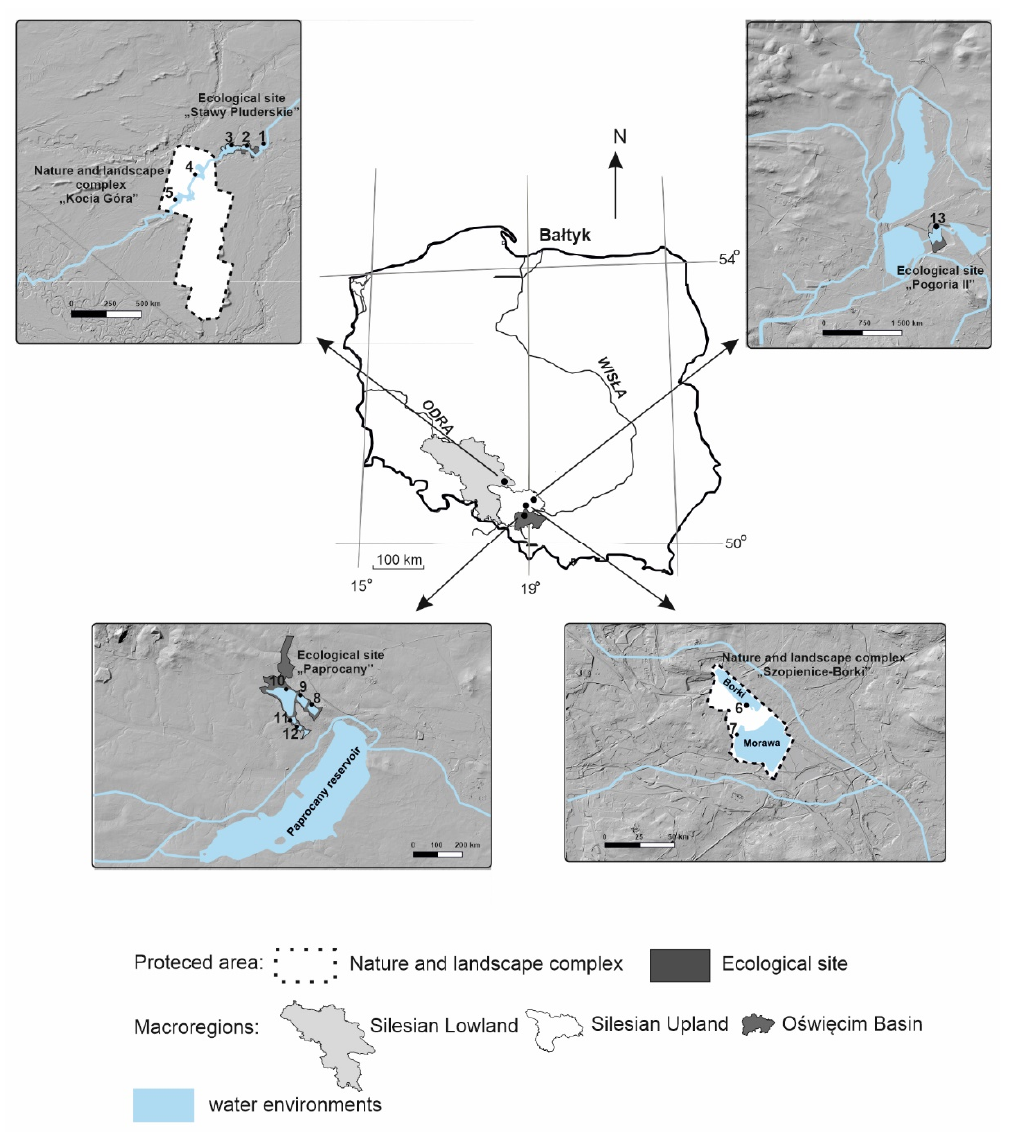
Figure 1. Location of the studied water bodies in the five protected complexes in Poland; 1–13 water bodies studied. Table 1. Environmental characteristics of the water bodies covered with different forms of habitat protection; Aquatic plant identification was performed by the authors; Data on Avifauna and Ichtiofauna and hydromorphology of habitats, physico-geographical mesoregions of Poland accord- ing to: Spałek et al., 2006 [33], Franczak U., Wójcicka-Rosińska A., 2013 [34], Tokarska-Guzik et al., 2002 [35]; nd- no data.